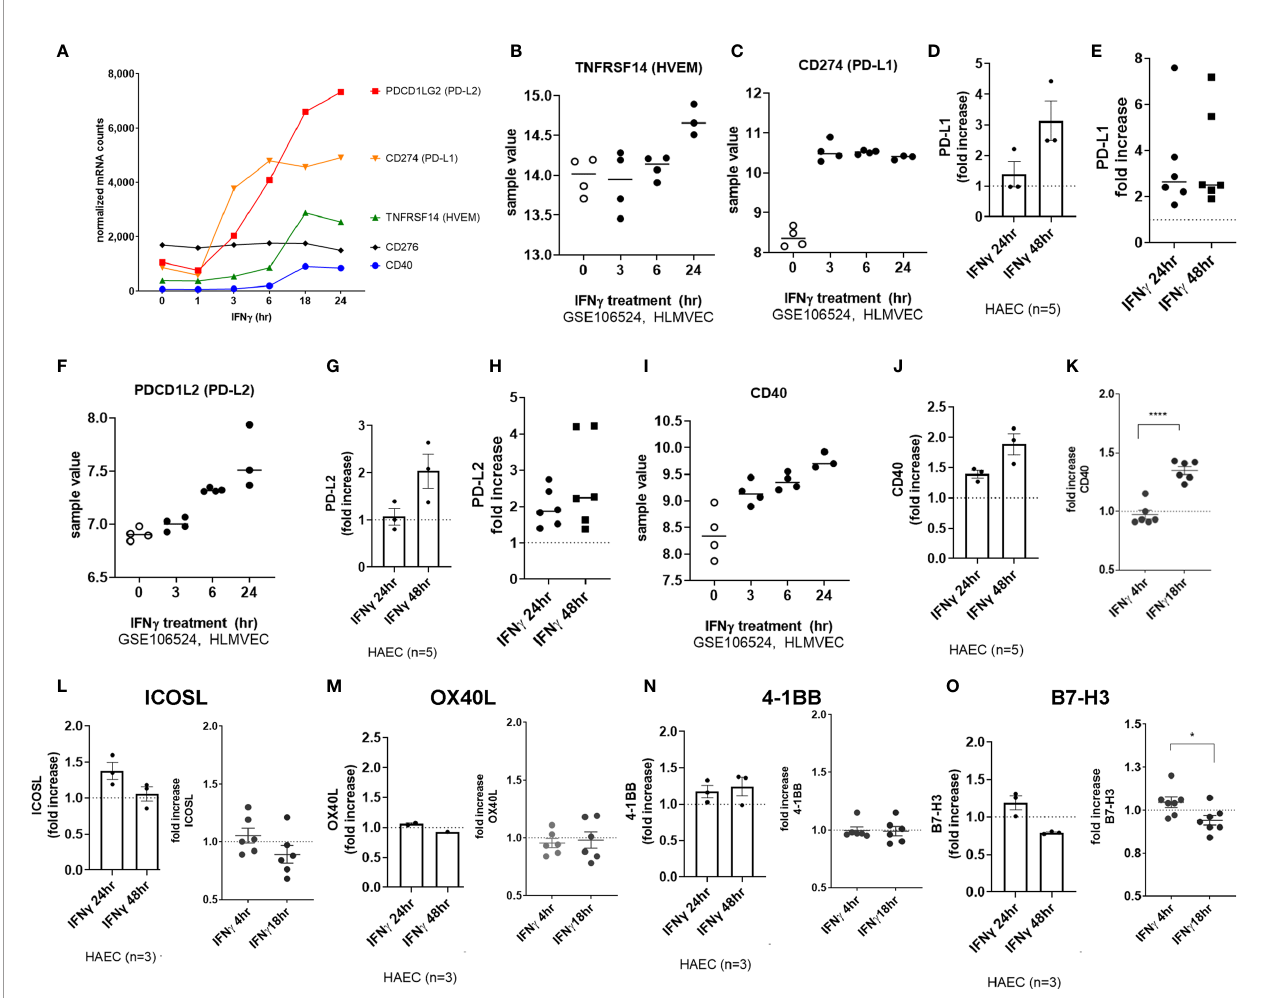
FIGURE 9 | IFN g induces endothelial expression of coinhibitory and costimulatory molecules. (A) HMEC-1 endothelial cells were stimulated with IFN g (200U/mL) for 1hr, 3hr, 6hr, 18hr or 24hr. Time course of IFN g induced transcripts in HMEC-1, for PDCD1LG2, CD274, TNFRSF14 , CD40 , and CD276 genes. One representative experiment is shown. Results are presented as absolute number of normalized mRNA counts for each gene, normalized to housekeeping controls. (B, C) Expression values of TNFRSF14 (B) and CD274 (C) from GSE106524 are plotted. Human lung endothelial cells were stimulated with IFN g for 3hr, 6hr or 24hr (n=3-4). (D) Primary human aortic endothelial cells (n=3 donors) were treated with IFN g for 24hr. Cell surface expression of PD-L1 was measured by fl ow cytometry (n=3). Results are presented as average fold increase in MFI of each molecule relative to untreated cells. (E) Primary human (HAEC, HCAEC, HCMVEC, HPAEC, HPMVEC, HLSEC) endothelial cells were treated with IFN g for 24hr or 48hr. Cell surface expression of PD-L1 was measured by fl ow cytometry (n=6). (F) Expression values of PDCD1L2 from GSE106524 are plotted. Human lung endothelial cells were stimulated with IFN g for 3hr, 6hr or 24hr (n=3-4). (G) Primary human aortic endothelial cells (n=3 donors) were treated with IFN g for 24hr. Cell surface expression of PD-L2 was measured by fl ow cytometry. Results are presented as average fold increase in MFI of each molecule relative to untreated cells. (H) Primary human (HCAEC, HCMVEC, HPAEC, HPMVEC, HRGEC, HLSEC) endothelial cells were treated with IFN g for 24hr or 48hr. Cell surface expression of PD-L2 was measured by fl ow cytometry (n=6). (I) Expression values of CD40 from GSE106524 are plotted. Human lung endothelial cells were stimulated with IFN g for 3hr, 6hr or 24hr (n=3-4). (J) Primary human aortic endothelial cells (n=3 donors) were treated with IFN g for 24hr. Cell surface expression of CD40 was measured by fl ow cytometry. Results are presented as average fold increase in MFI of each molecule relative to untreated cells. (K) Primary human (HCAEC, HCMVEC, HPAEC, HPMVEC, HRGEC, HLSEC) endothelial cells were treated with IFN g for 24hr or 48hr. Cell surface expression of CD40 was measured by fl ow cytometry (n=6). (L-O) Primary human (HAEC [n=3], HCAEC, HCMVEC, HPAEC, HPMVEC, HRGEC and HLSEC) endothelial cells were treated with IFN g for 4hr, 18hr, 24hr or 48hr. Cell surface expression of (L) ICOSL, (M) OX40L, (N) 4-1BB and (O) B7-H3 was measured by fl ow cytometry. *p < 0.05, ****p < 0.0001 by paired t